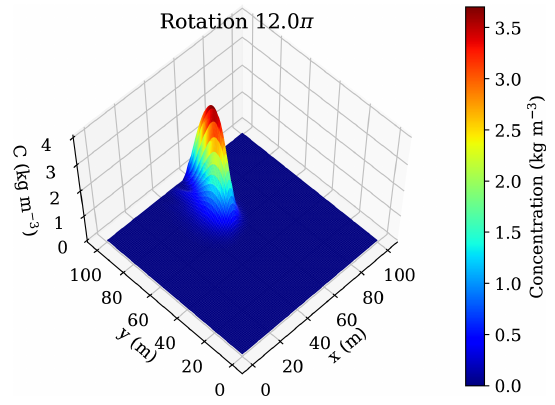
Figure 9. Cone shape and maximum tracer concentration ( C = 3 . 718kgm − 3 ) after six full rotations for the Smolarkiewicz advec- tion scheme, which preserves more than 96% of the initial maxi- mum tracer